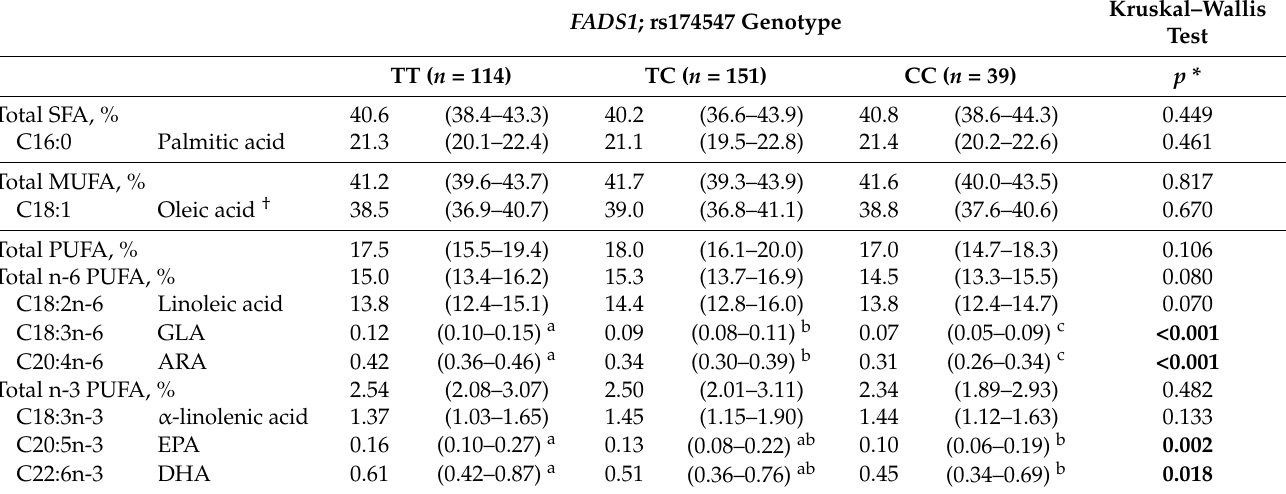
Table 2. Fatty acid compositions in human milk by FADS1 rs174547 genotypes.